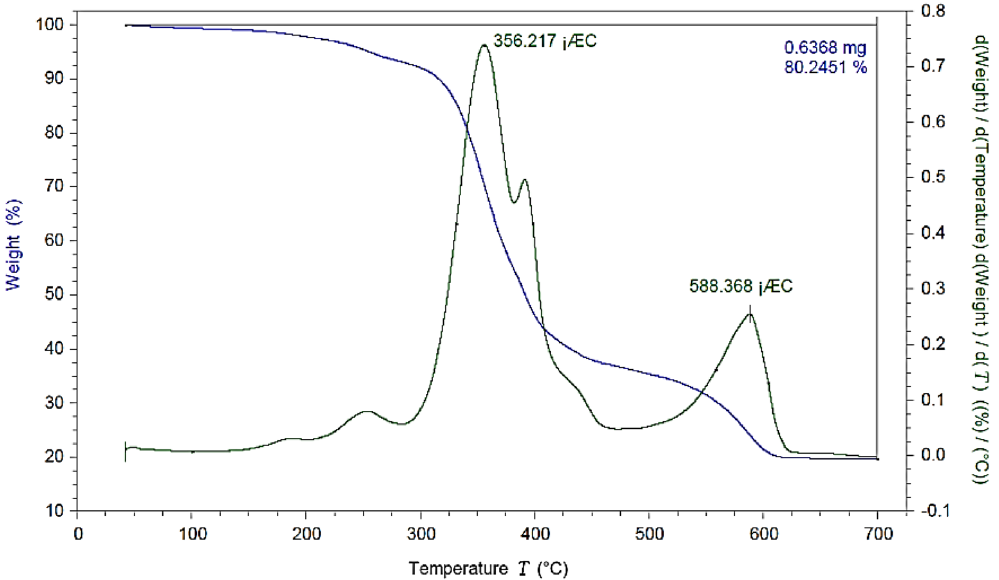
Figure 11. TG/DTG analysis of Ps@Tet-Cu(II)@Fe 3 O 4